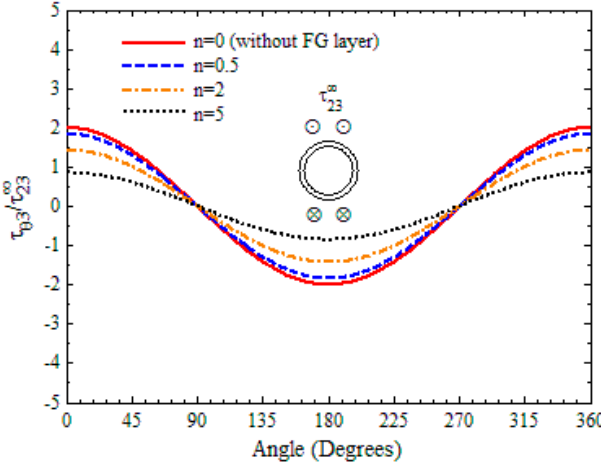
Figure 3. The variation in shear stress τ θ 3 around the hole (circle).